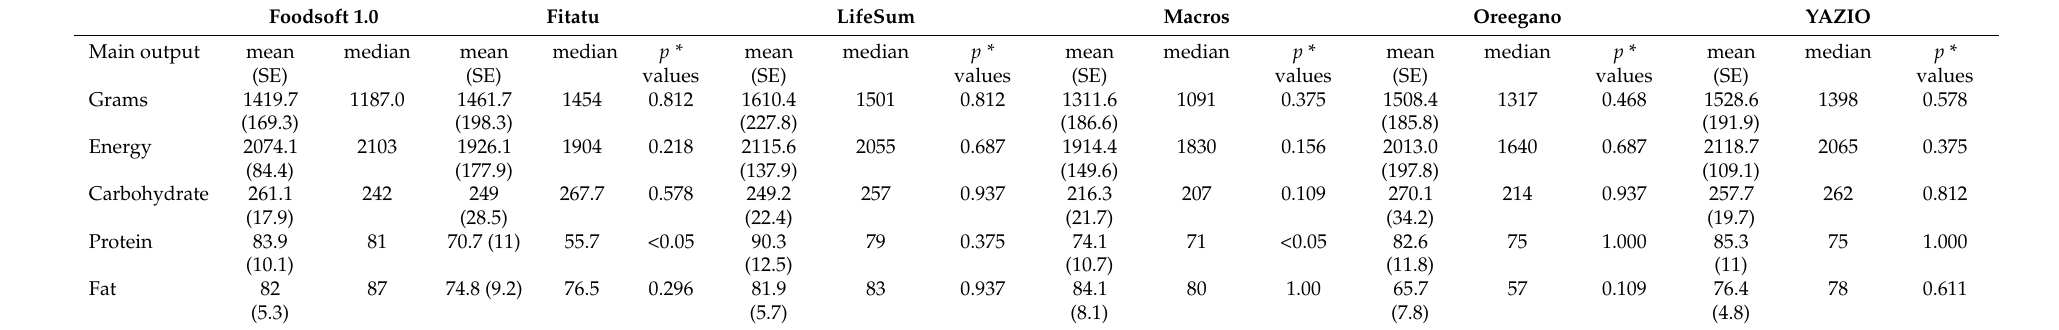
Table 4. Median, mean and standard error of mean (SE) of nutrient intake estimated by Foodsoft 1.0 and the five apps for the seven 24-HRs